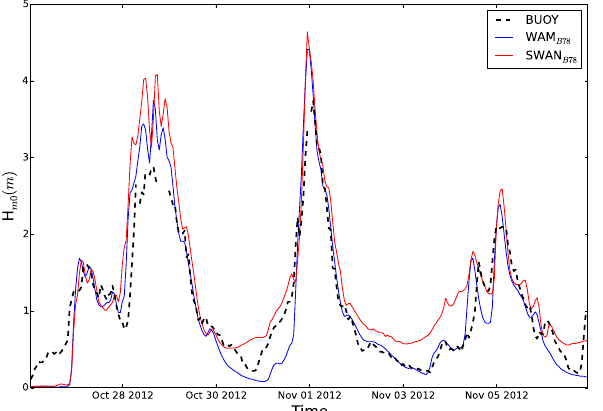
Table 3. Statistics for the Venezia forecast